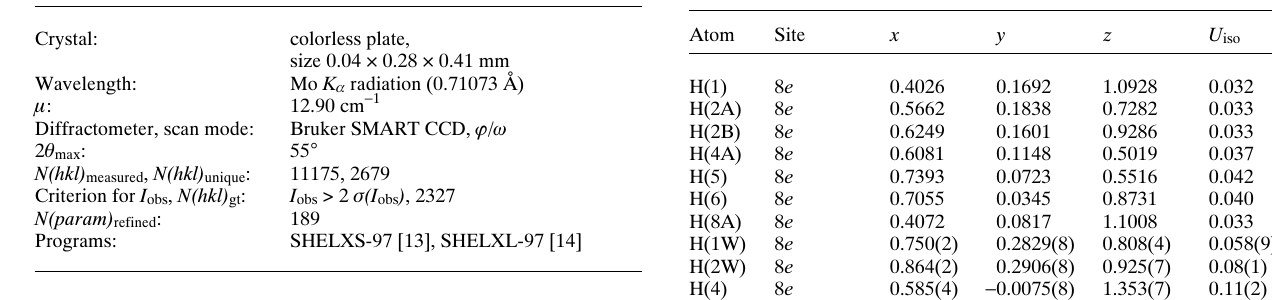
Table 2. Atomic coordinates and displacement parameters (in Å 2 ) . Table 1. Data collection and